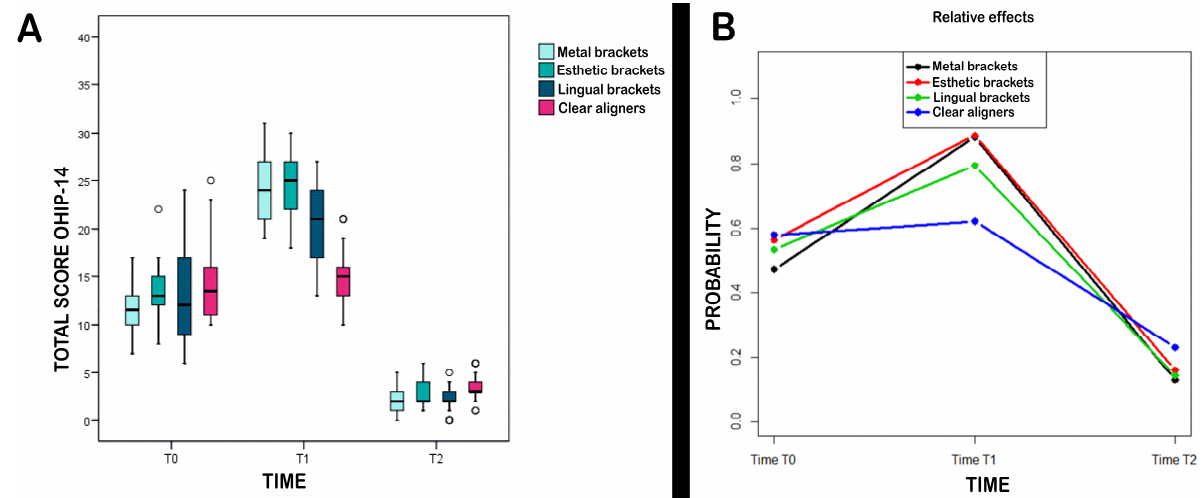
Figure 1 . ( A ) Comparison between four types of orthodontic treatment at three study times (T0, T1, and T2); ( B ) Relative